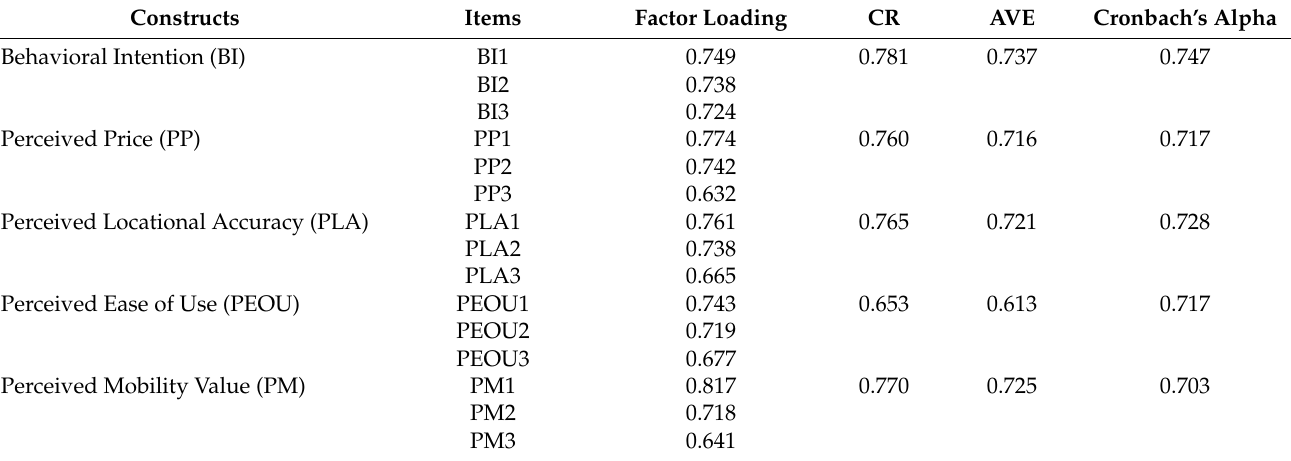
Table 6. Standardized item loadings, AVE, CR, and alpha